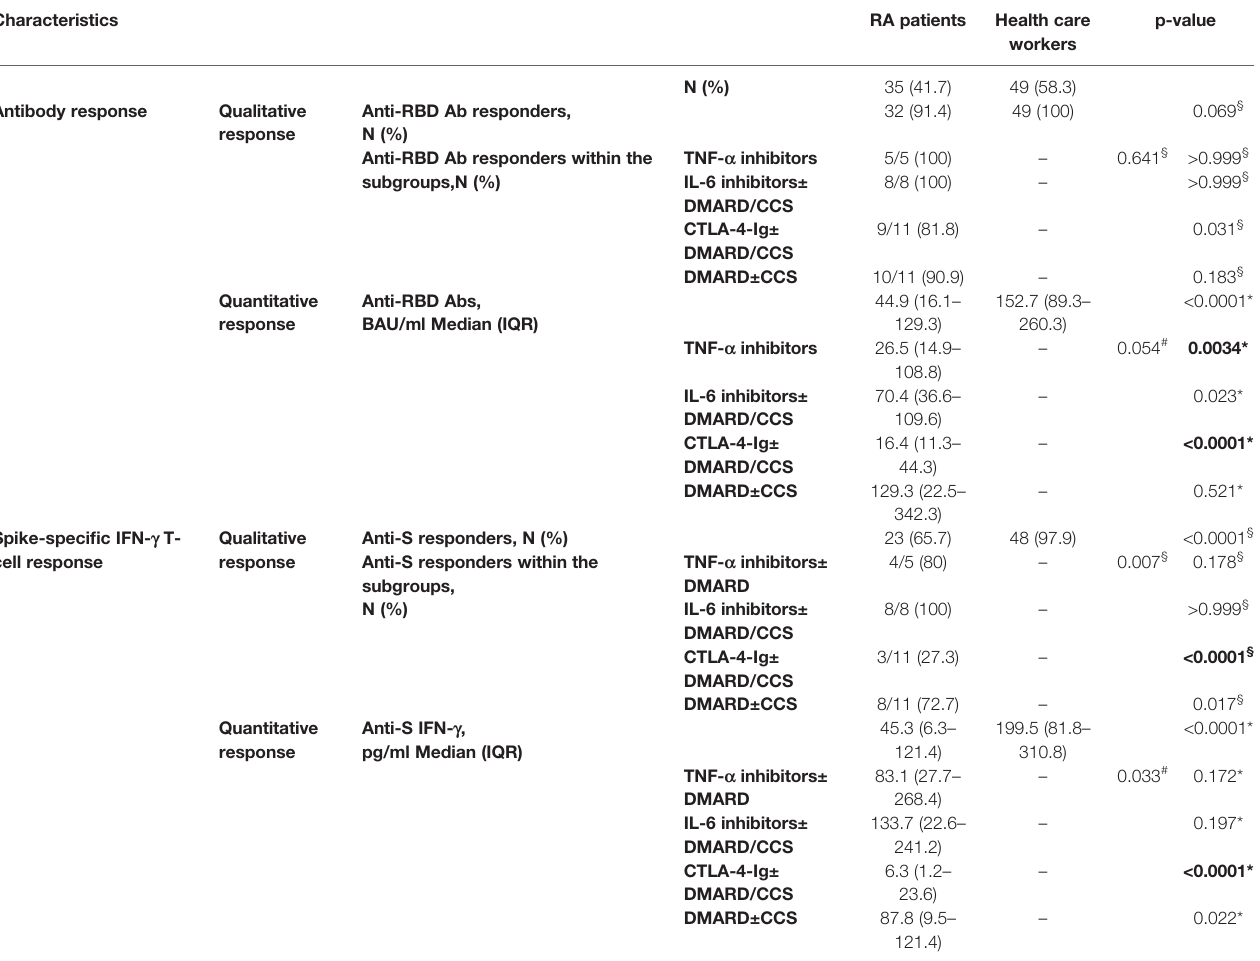
TABLE 2 | Serological and T-cell speci fi c response at